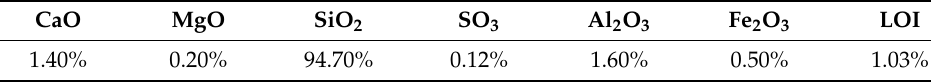
Table 4. Chemical properties of Jhelum aggregates.